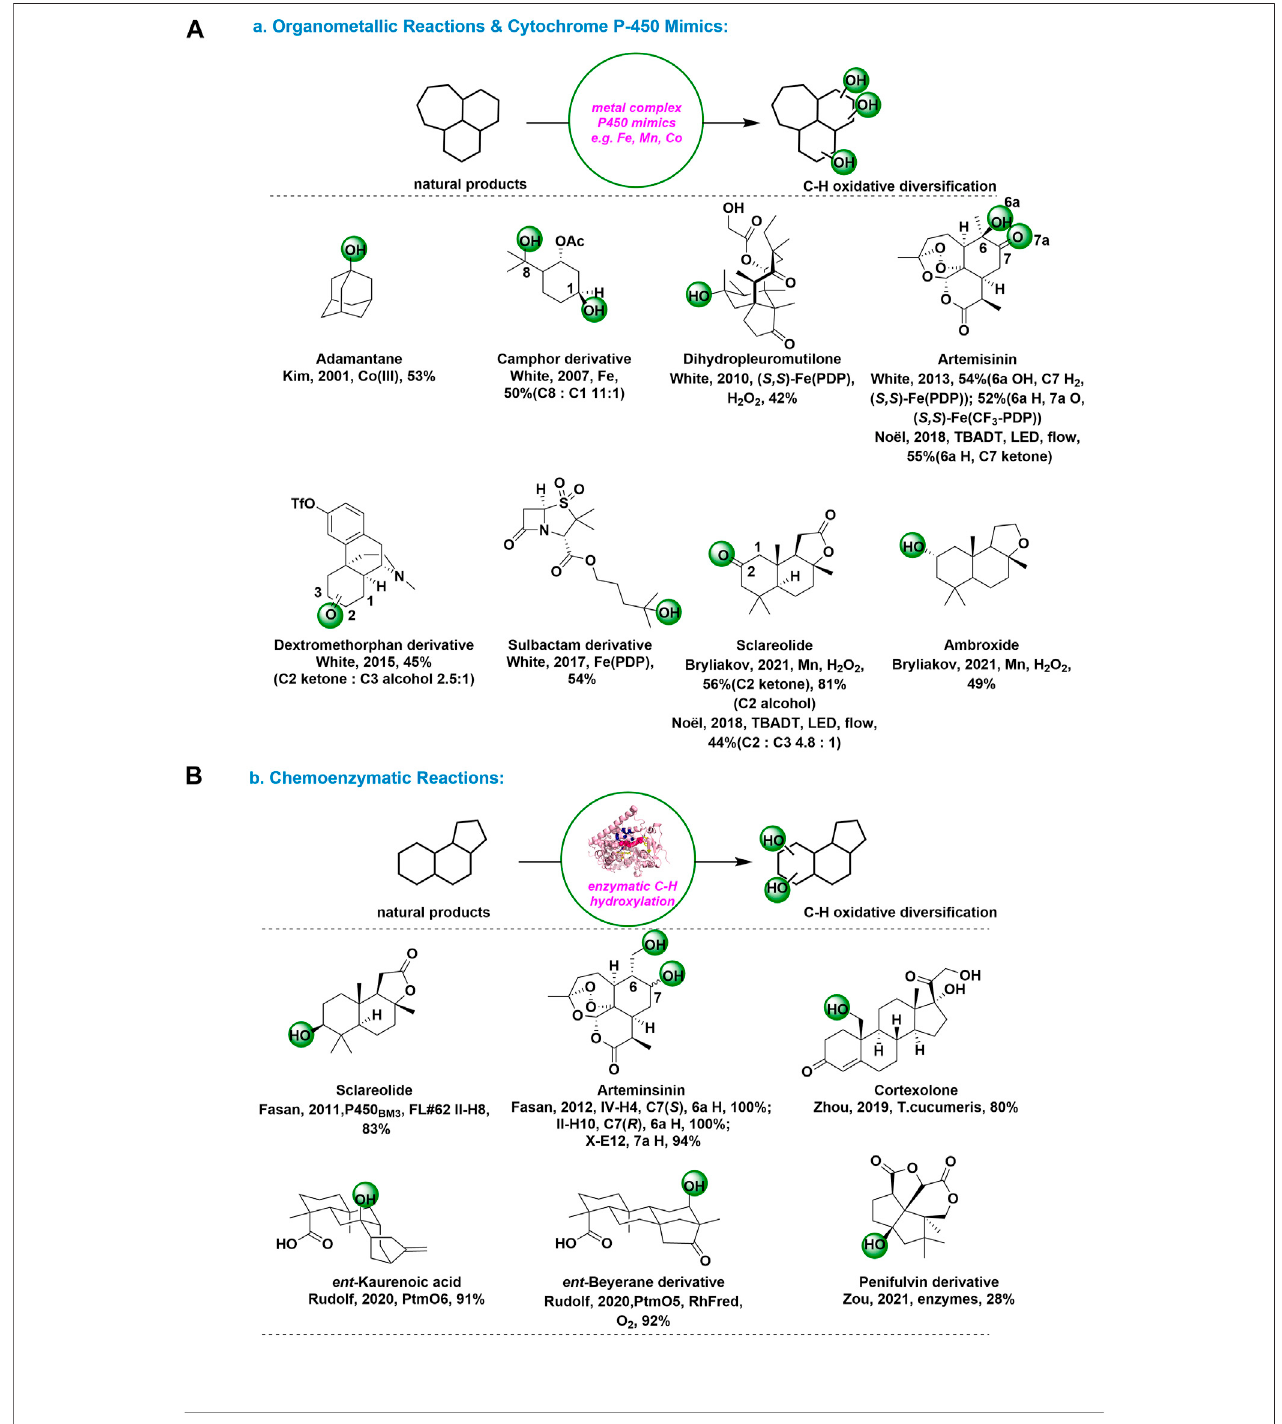
FIGURE 2 | C-H Oxidations for natural products and complex molecules: (A) organometallic reactions and cytochrome P-450 mimics; (B) Chemoenzymatic reactions.